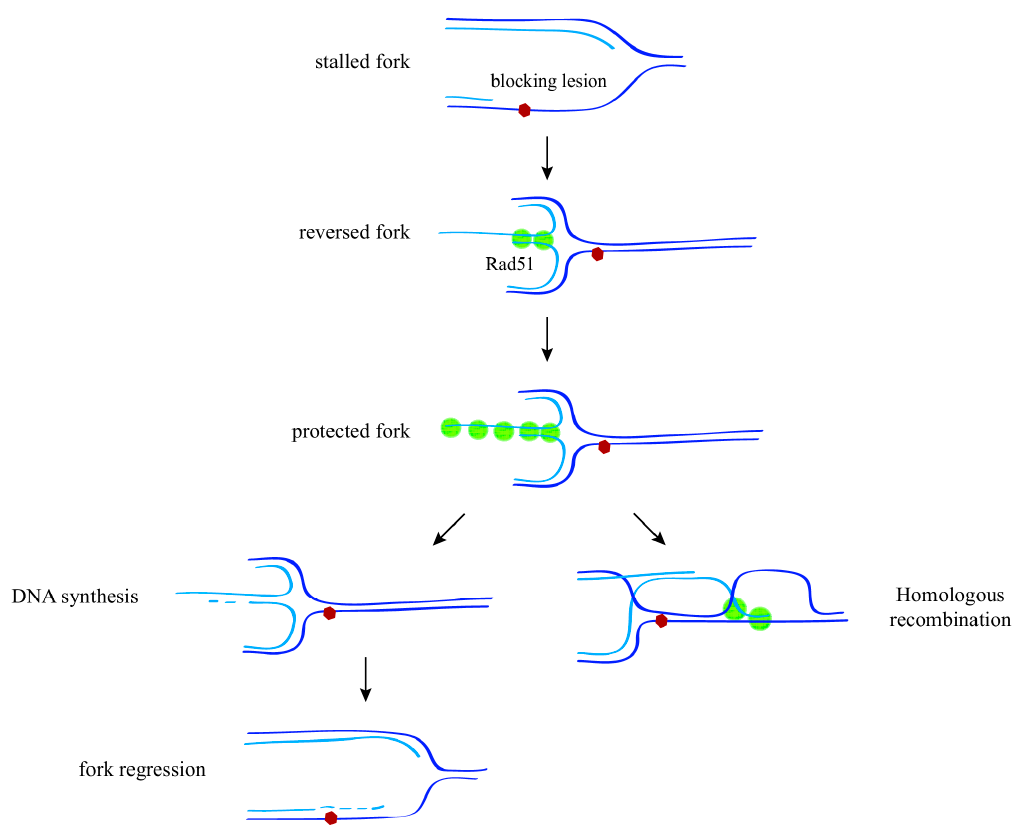
Figure 2. Mechanisms of replication fork protection and restart upon replication stress. In response to replication stress (e.g., a blocking lesion that uncouples DNA unwinding from DNA synthesis), displacement and further reannealing of the nascent strands leads to the formation of a reversed fork through a process that requires the recombination protein Rad51. Stabilization of a Rad51 nucleofilament at this structure is required to protect the fork against nuclease degradation. Reversed forks might facilitate lesion bypass by either DNA synthesis and fork regression, or strand invasion ahead of the fork, thus reducing the need for post-replicative ssDNA repair.